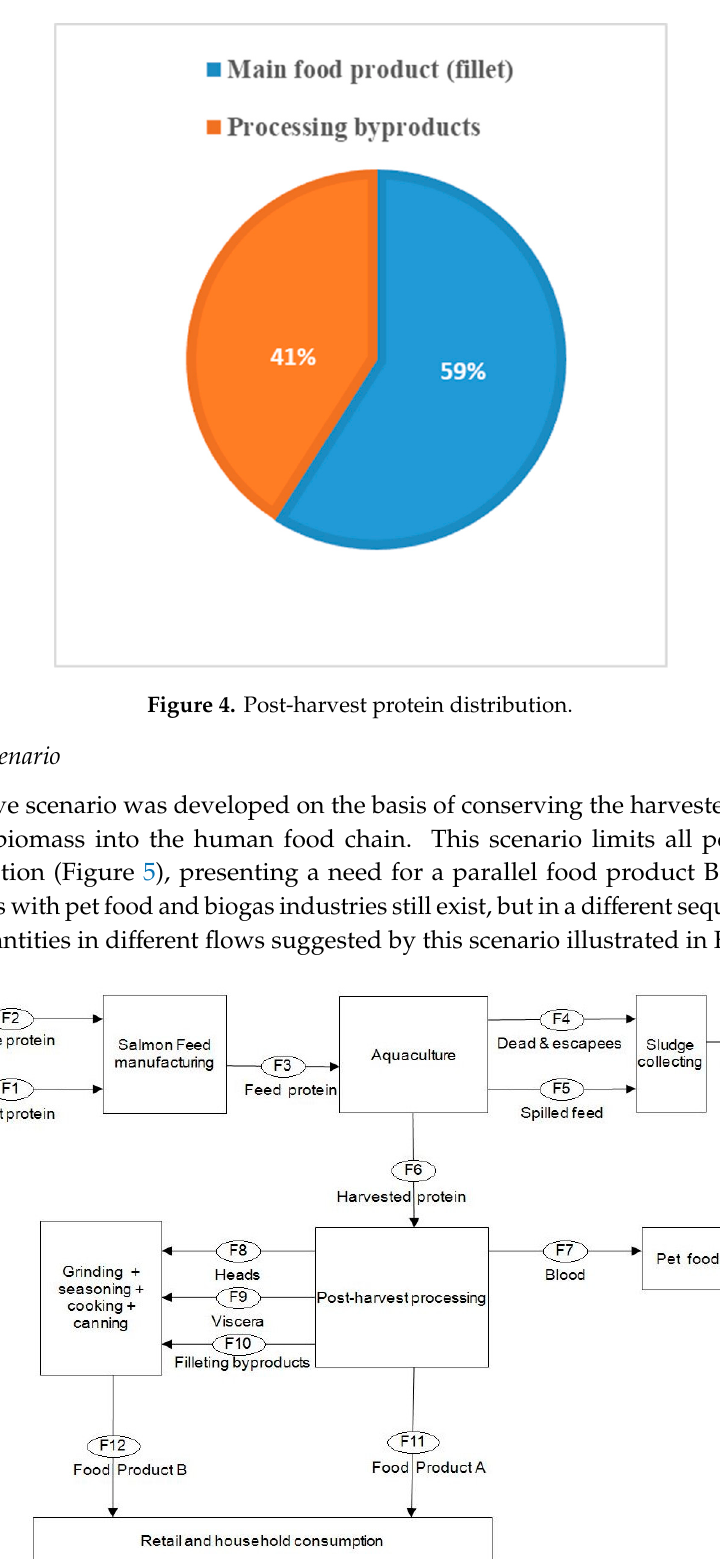
Figure 3. Marine animal protein quantities.